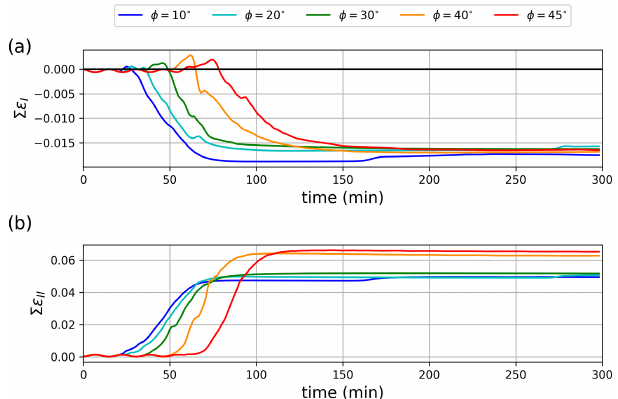
Figure 10. Time evolution of (a) the mean normal strain rate invari- ant integrated over the ice cover (d − 1 ) and (b) the maximum shear strain rate invariant integrated over the ice cover (d − 1 ), when using different angles of internal friction φ , with a stress correction path normal to the yield curve ( γ = arctan (µ) ).